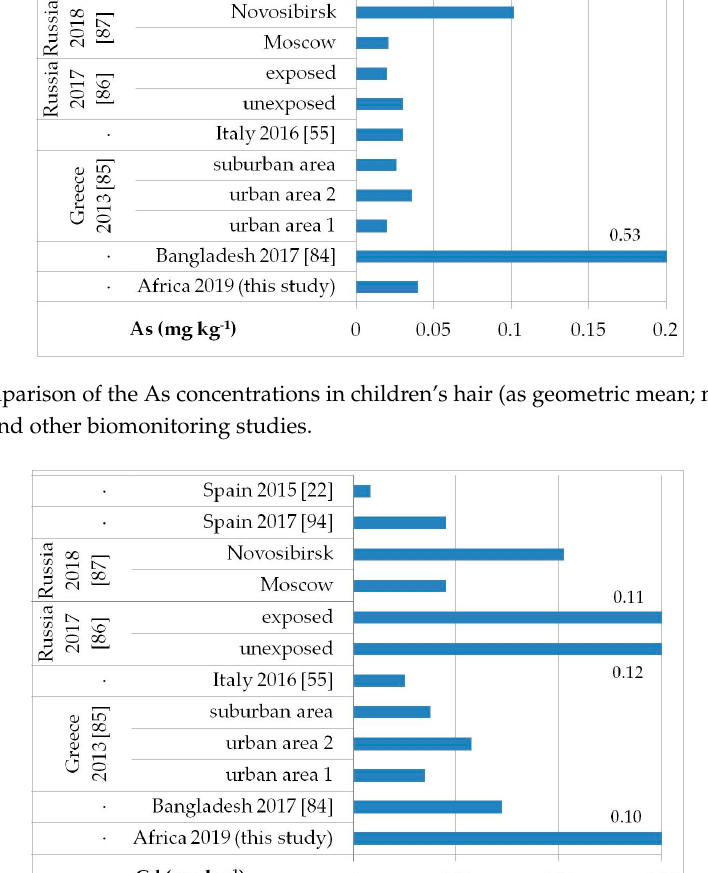
Figure 4. Comparison of the Hg concentrations in children’s hair (as geometric mean; mg kg − 1 ) found in our study and other biomonitoring studies. Figure 5. Comparison of the Pb concentrations in children’s hair (as geometric mean; mg kg − 1 ) found in our study and other biomonitoring studies. 3.2. Factor and Correlation Analysis The population characteristics are shown in Table 1. A total number of 81 children’s hair samples were collected, with a similar proportion of boys (51.1%) and girls (48.9%). Overall, 40.8% of children were aged 6–11 years and 29.6% were both <5 and 12–18-year-old. Of all children, 87.7% were underweight (BMI < 18.5).